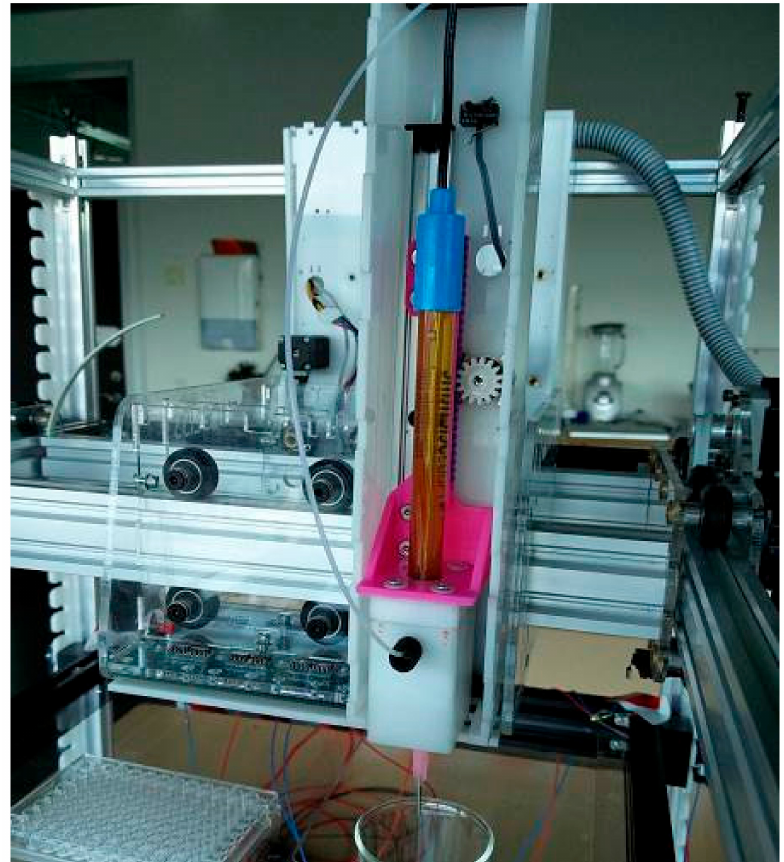
Figure 10. A pH module developed by a student. The module was designed by modifying the dispensing